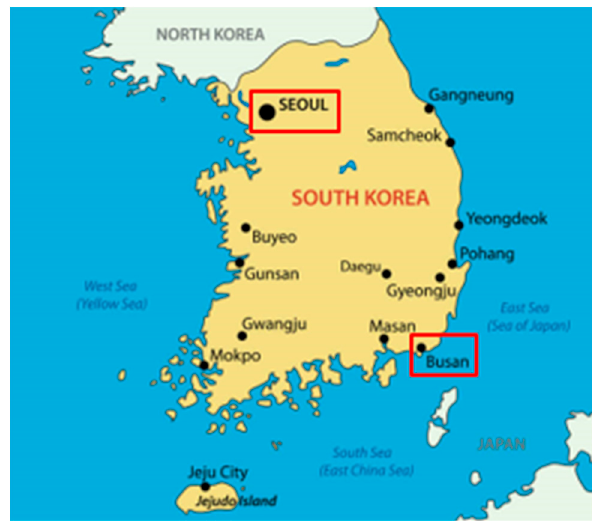
Figure 9. The LSTM / GRU model. Figure 9. The LSTM/GRU model.